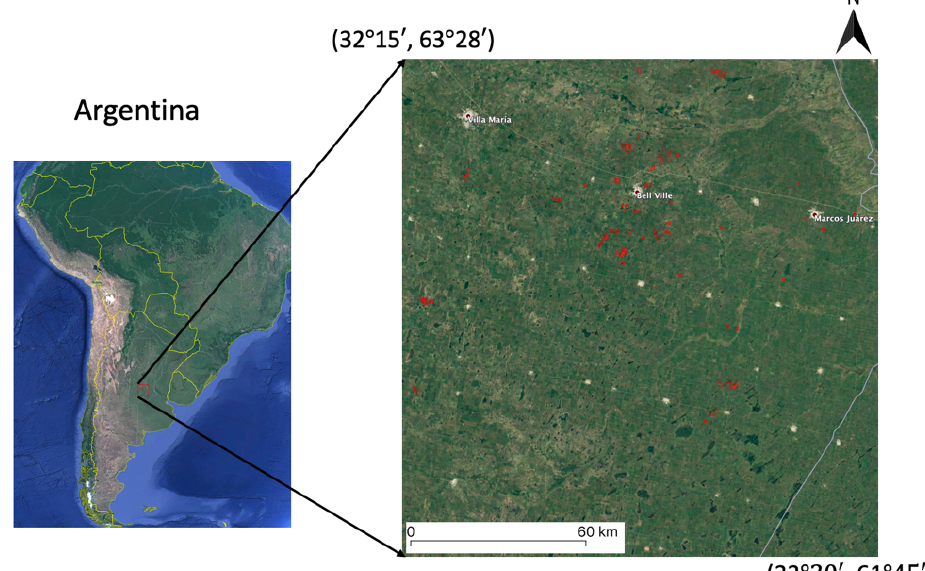
Figure 1. Study area in central Argentina. The soybean fields are shown in red